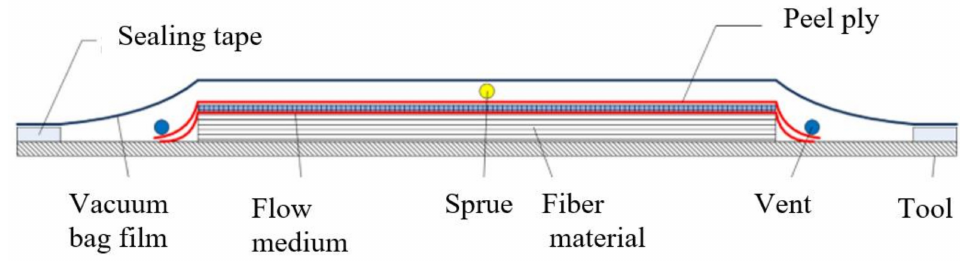
Figure 13. Schematics of the SCRIMP process [109]. Reprinted with permission from